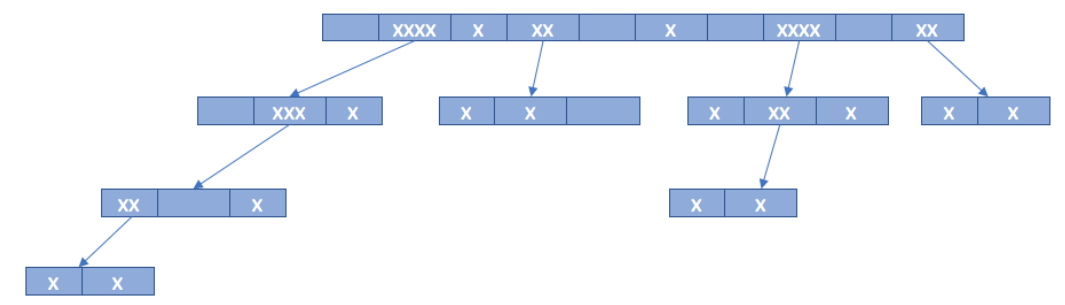
Figure 21. An example of Tree Slotted Aloha